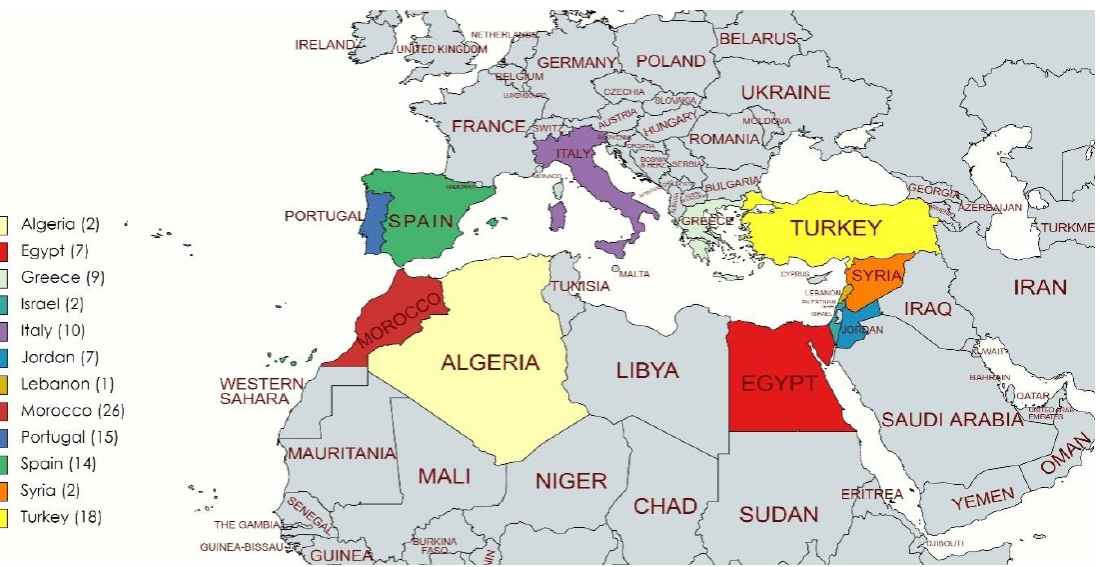
Figure 1. Geographical distribution of durum wheat accessions used in the present study.